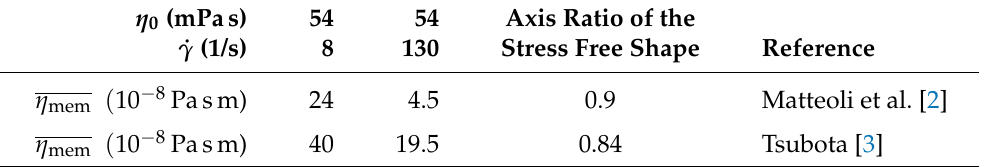
Table 1. Conflicting results in η mem upon fitting the same experimental